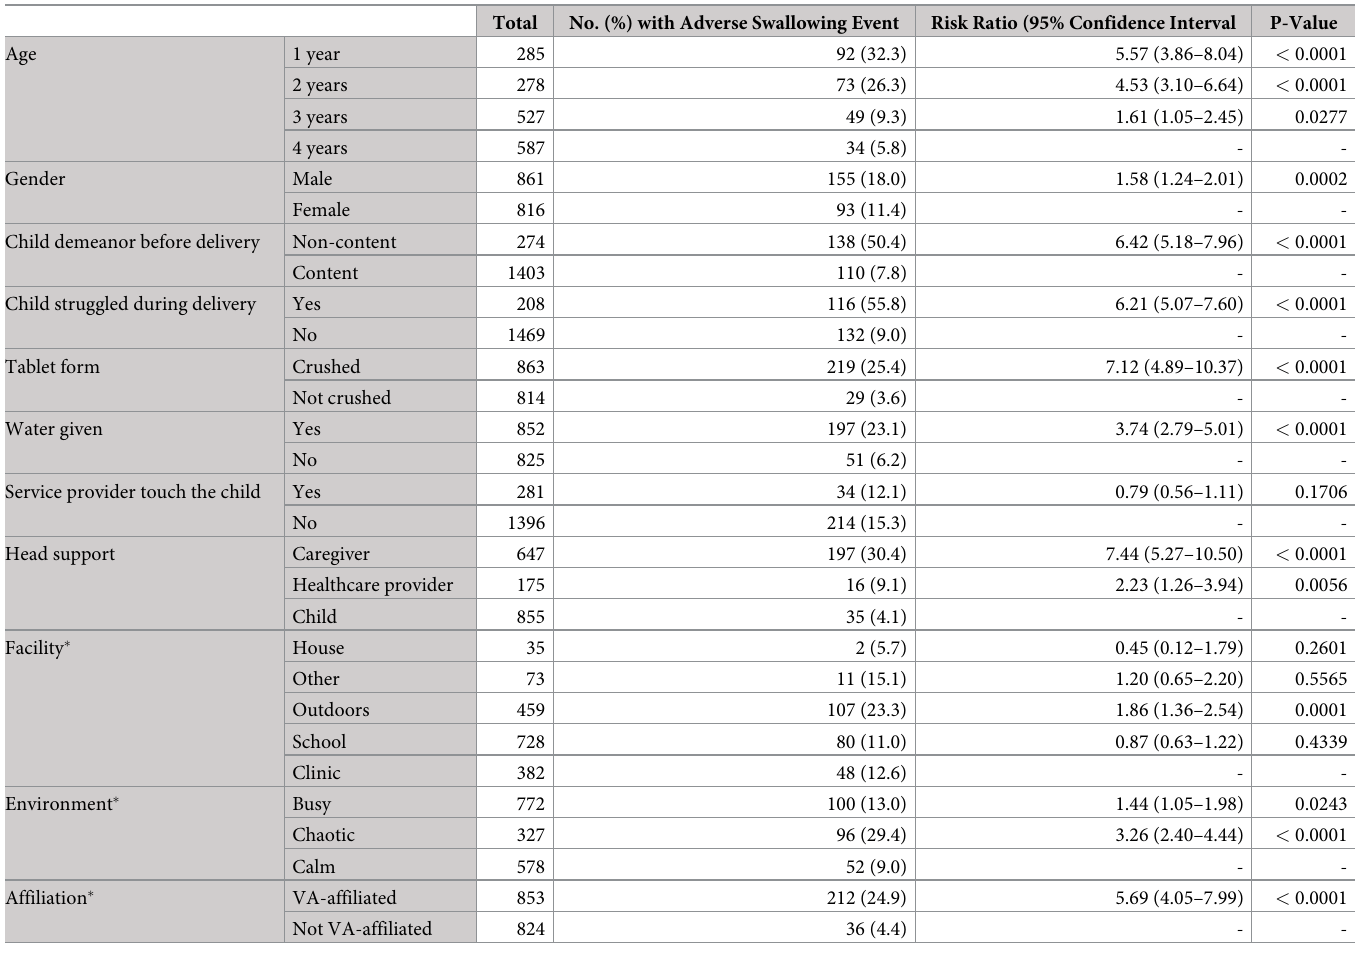
Table 1. Risk of adverse swallowing events by child-related factors, drug administration, and drug distribution setting, Haiti and India, 2017. Total No. (%) with Adverse Swallowing Event Risk Ratio (95% Confidence Interval